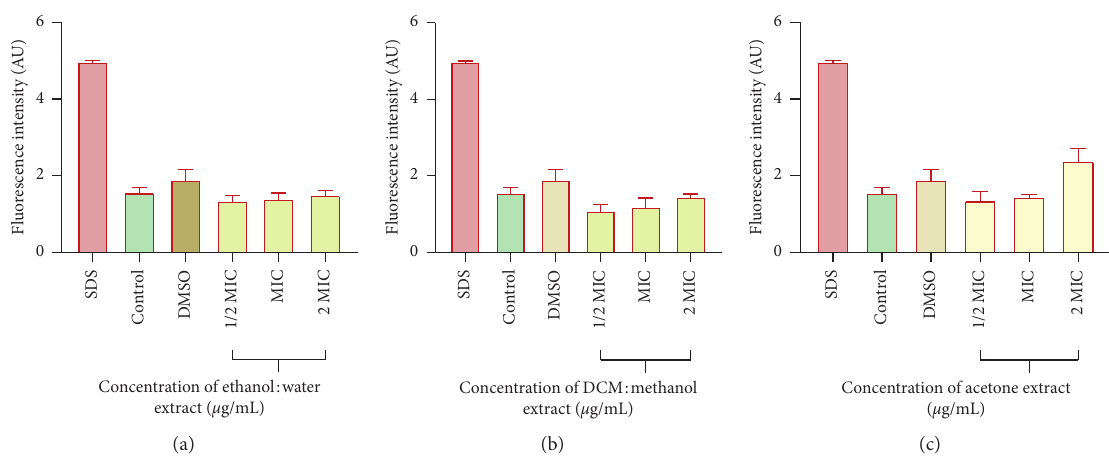
Figure 2: Effect of leaf extracts from P. americana on nucleic acid leakage from (S) epidermidis cells at 1/2 MIC, MIC, and 2 MIC. (a) Ethanol:water extract, (b) DCM:methanol extract, and (c) acetone extract. The values shown are for mean ± standard deviation for n � 3. Untreated cells were the negative control and SDS (sodium dodecyl sulphate) was the positive control. The asterisks indicate a significant difference from the control with ∗ p < 0 . 05 and ∗∗∗ p < 0 . 001.